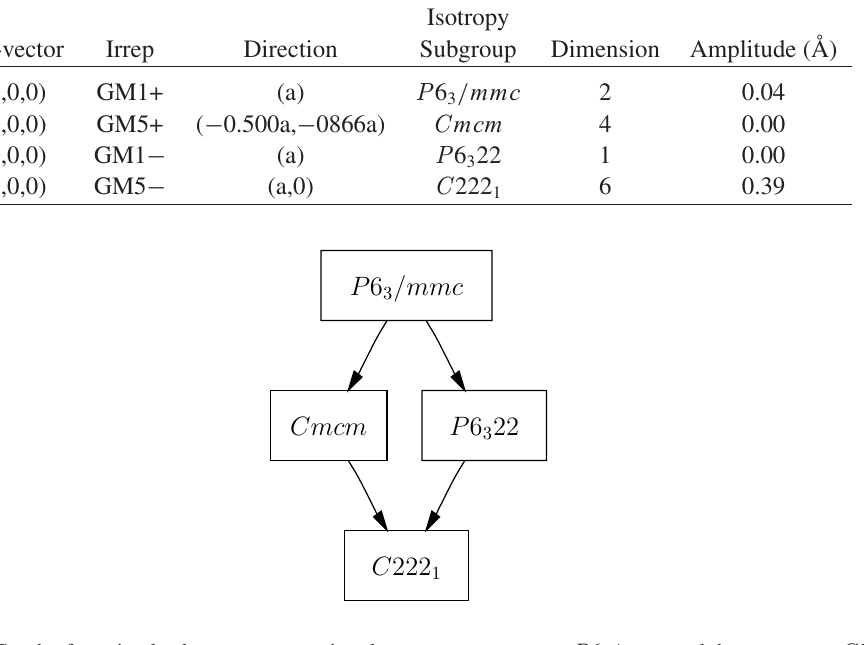
Figure 8. Graph of maximal subgroups connecting the parent space group P 6 3 /mmc and the symmetry C 222 1 of SrMnO 3